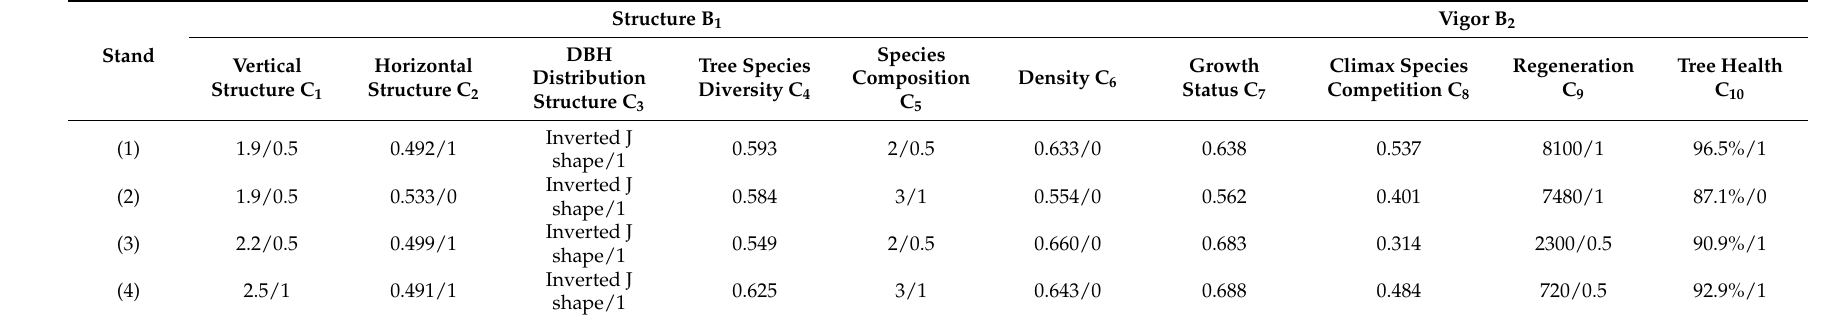
Table 2. State characteristics of different natural forests (original value/normalized